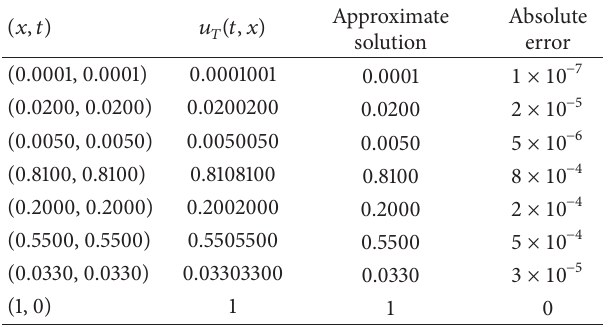
Table 1: Comparison of the absolute error 𝜀 = 1 × 10 −3 .